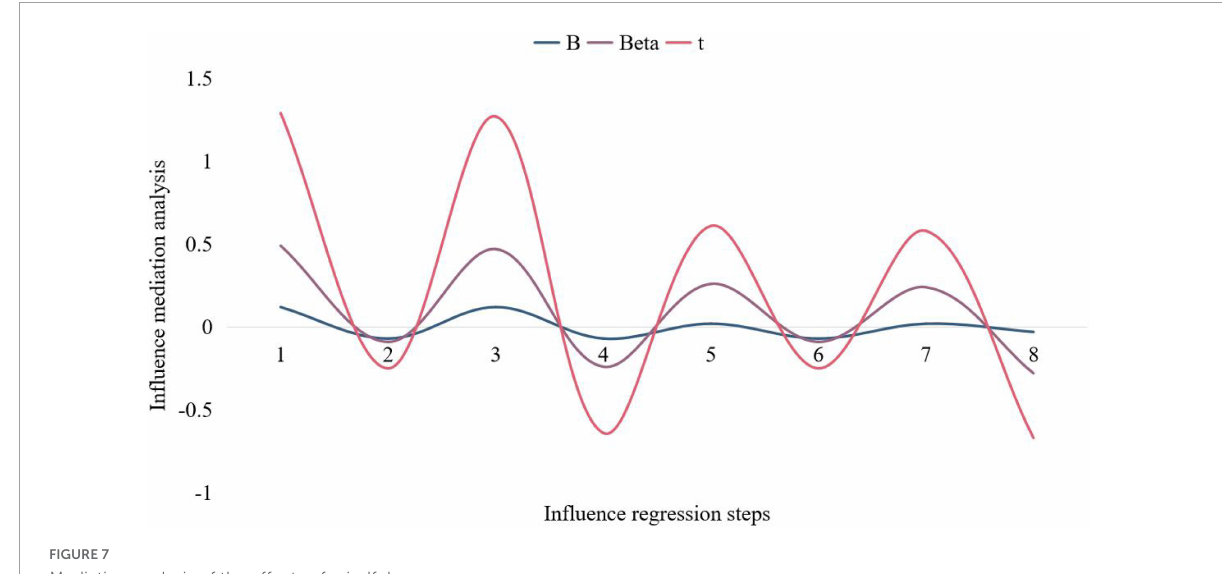
FIGURE7 Mediation analysis of the effects of mindfulness.